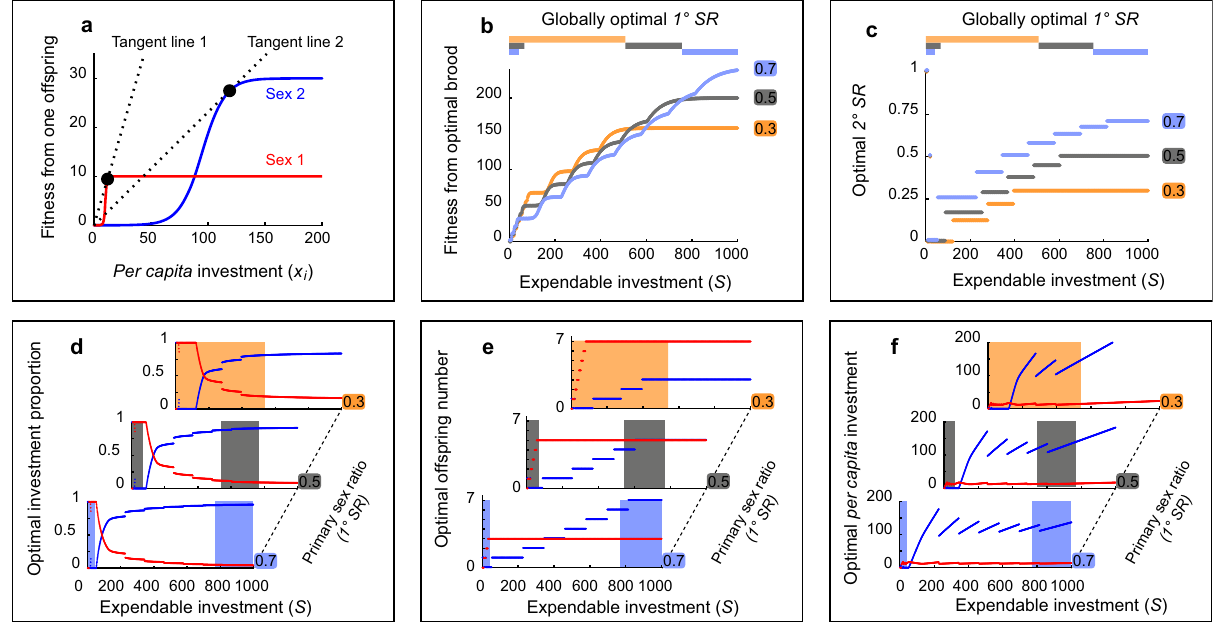
Fig. 3 The results from model M3 (fully presented in Fig. S3), in which predictions from the classical TWH hold with respect to the total number of offspring receiving care and total investment toward the speci fi c sex: Sex 2 is preferred over Sex 1 when S is high. a The fi tness functions of Sex 1 (red line) and Sex 2 offspring (blue line) in model M3 . In this model, the tangent line of Sex 1 is steeper than that of Sex 2 . b The relationship between total investment ( S ) and fi tness accrued from the whole brood for three different primary sex ratios (0.3, 0.5, 0.7; yellow, gray, and light blue, respectively) by parents that optimize their parental strategy. The horizontal color bars on top of the panel represent the ranges of S in which the speci fi c primary sex ratio(s) yield the highest value of fi tness accrued from the optimal brood. The same bars are presented in c and these regions of S are indicated as shaded regions of the same color in d – f . c The relationship between total investment ( S ) and the brood ’ s secondary sex ratio for the three different primary sex ratios (same color schematics as in b ) for parents that optimize their investment. d – f The relationship between total investment ( S ) and the three aspects of the optimal parental strategy: proportion of investment ( d ), optimal numbers of offspring chosen for investment ( e ), and per capita investment ( x i ) into Sex 1 (red) and Sex 2 (blue) offspring ( f ) for three different primary sex ratios. Color-shaded (same color schematics as in b ) regions indicate the globally optimal strategy: in each primary sex ratio, shadings indicate the range of S in which fi tness from the brood is globally maximized (as seen in b ). Broods with fi tness functions different for males and females . investment is small (see Methods). For each pair of fi tness functions, Then, we focused on broods composed of two sexes, Sex 1 and Sex 2 we simulated three types of clutches with different 1° SR s: Sex - 1 - (marked in red and blue lines, respectively, in Figs. 3a, 4a), that biased ( 1° SR = 0.3; for convenience, we express sex ratio as the differed in the shape of the fi tness functions. Figures 3 and 4 proportion of Sex 2 offspring in the clutch), equal ( 1° SR = 0.5), or represent two examples (models M3 and M5 ) chosen from all Sex - 2 -biased ( 1° SR = 0.7) clutches. Three sex ratios were marked computational models that simulate broods with 14 cases of different with orange, gray, and light blue in Figs. 3, 4, respectively. fi tness function pairs (SM, Part 3). In all pairs of Sex 1 and Sex 2 For each pair of fi tness functions (Figs. 3a, 4a; panels (a) in functions, it holds that Sex 1 has greater fi tness when per capita Figs. S3 – S16), we calculated the fi tness accrued by optimally COMMUNICATIONS BIOLOGY| (2022) 5:371